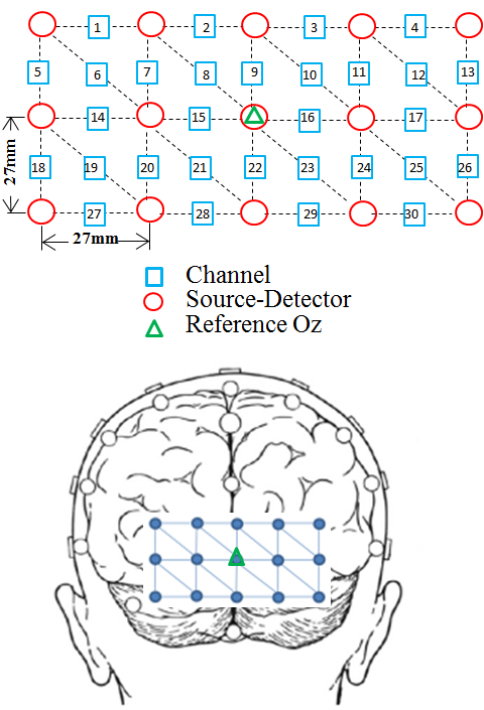
Fig. 1. Optodes con¯guration: The numbers represent the measurement channels; Oz refers to a reference point in the International 10 – 20 System.